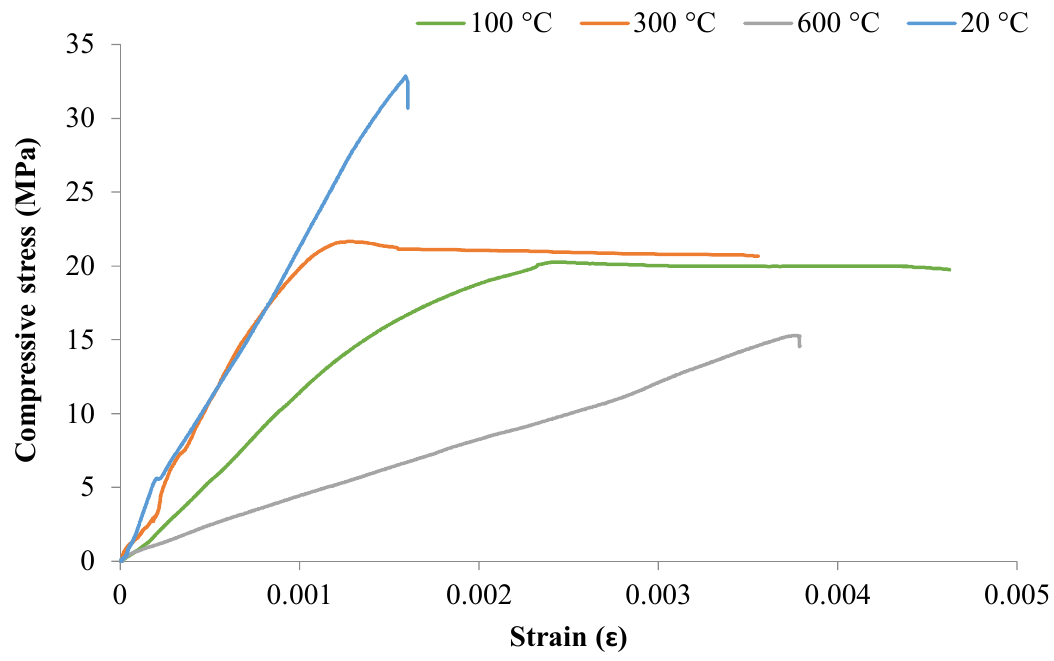
Materials 2019 , 12 , x FOR PEER REVIEW Figure 9. Compressive stress–strain curves for M2 after 28 days at high temperatures.